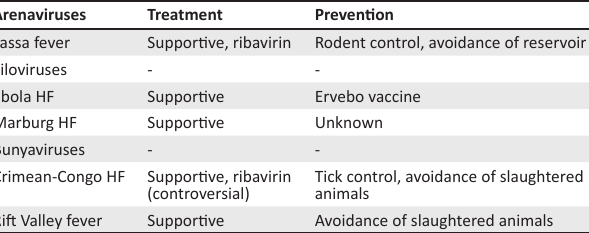
TABLE 3: Therapeutic and preventative measures specific for selected viral haemorrhagic fever. Arenaviruses